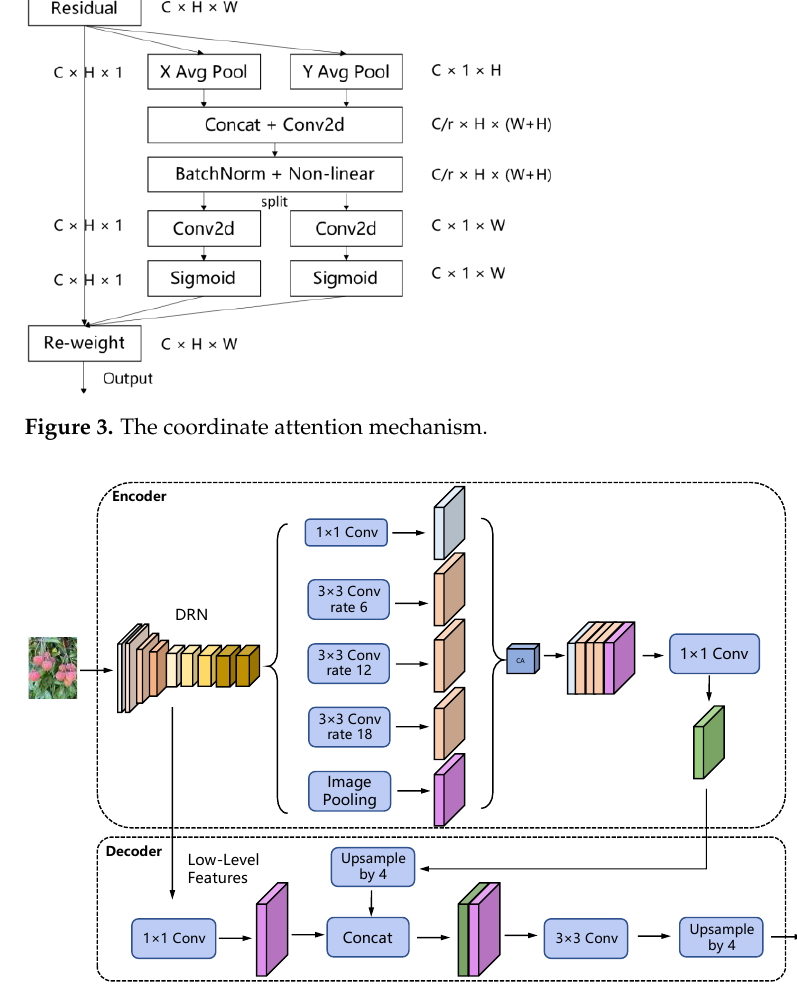
Figure 4. The improved DeepLabv3+ network structure.